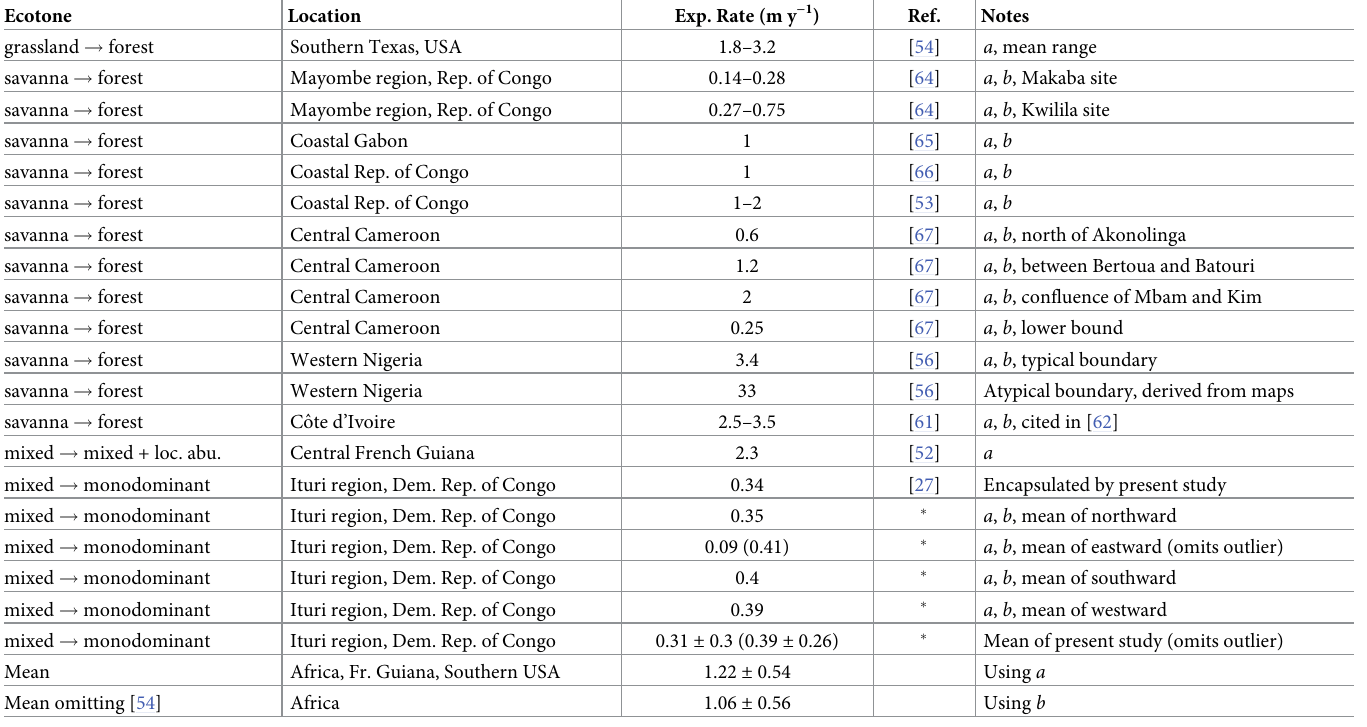
Table 3. Edge diffusion-based expansion rates in forest succession among different ecotones.